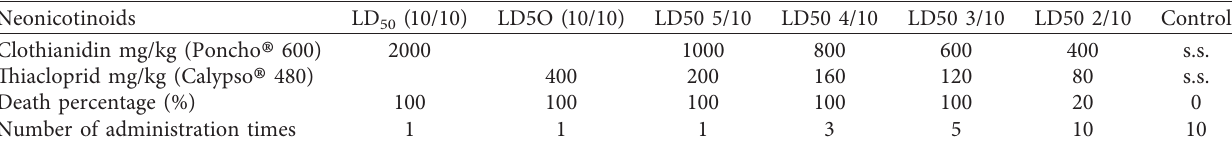
Table 1: Determination of the subchronic administration scheme from the LD50 reported by the manufacturer. Neonicotinoids